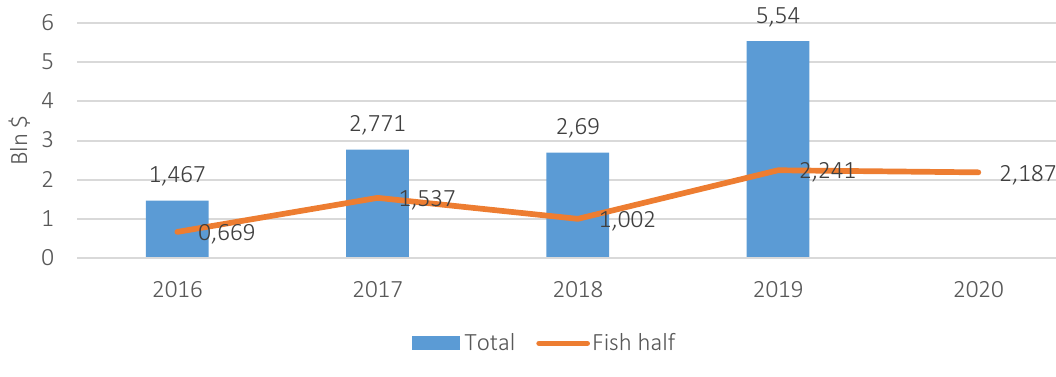
Figure 2. Global investments in InsurTech for 2016 – first half of 2020